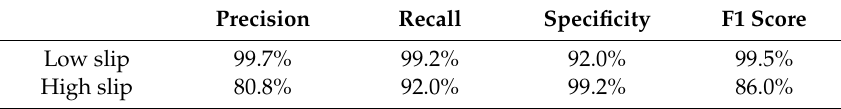
Table 8. Performance metrics of the slippage classifier.